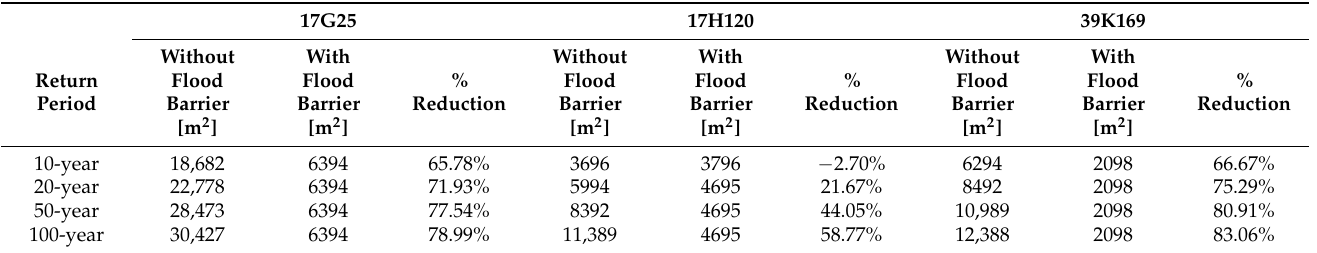
Table 2. Flood extents for manholes with and without flood protection barriers for all return periods in m 2